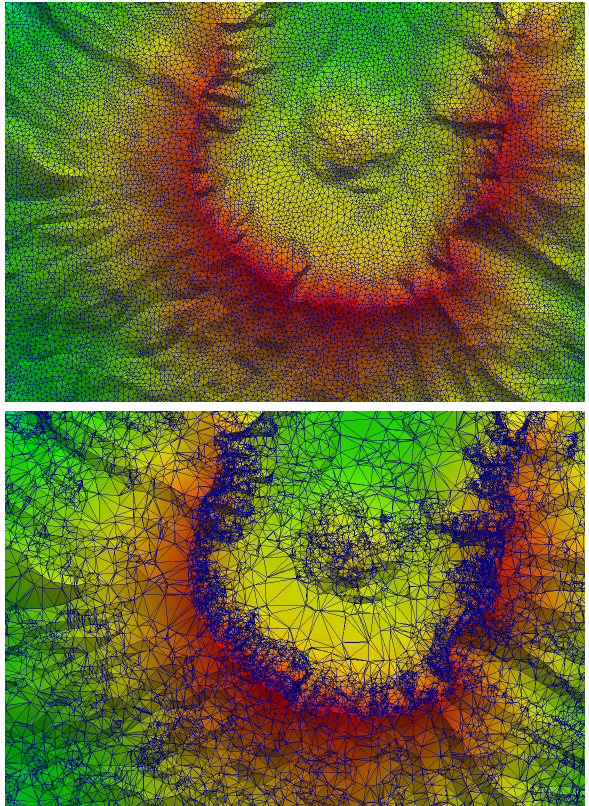
Figure 12. Visual examination of St. Helens. Top: cCVT grid. Bot- tom: HFPR grid. The latter grid appears more rigid than the former, which implies a stronger generalisation effect.